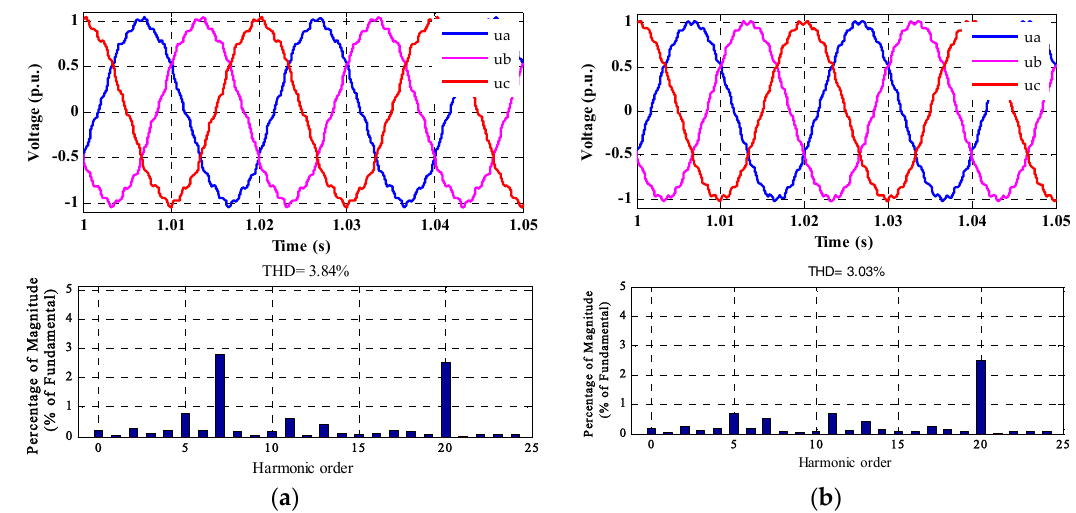
Figure 14. Simulation results of 20th harmonic testing. ( a ) 3-phase voltage waveform and spectrum without damping 7th harmonic; ( b ) voltage waveform and spectrum after damping 7th harmonic.